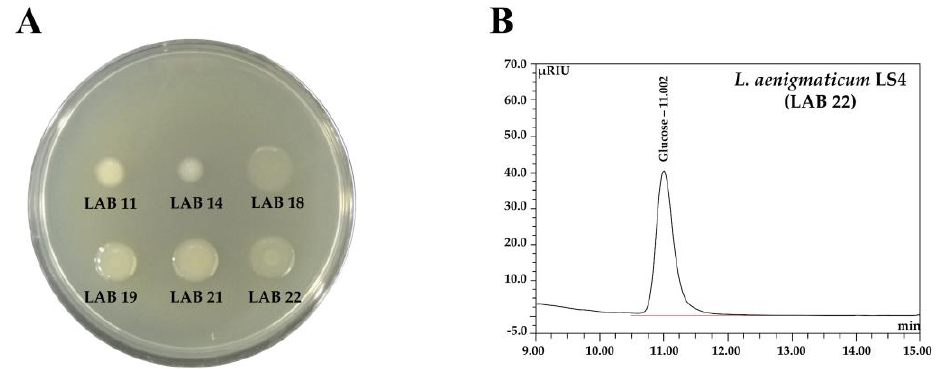
Figure 3. EPS production by LAB isolates. EPS production on a sucrose plate ( A ), and HPLC chromatogram obtained after acid hydrolysis of the EPS produced by L. aenigmaticum LS4 ( B ). Table 5. Antimicrobial activities of L. aenigmaticum LS4 against molds and bacteria.